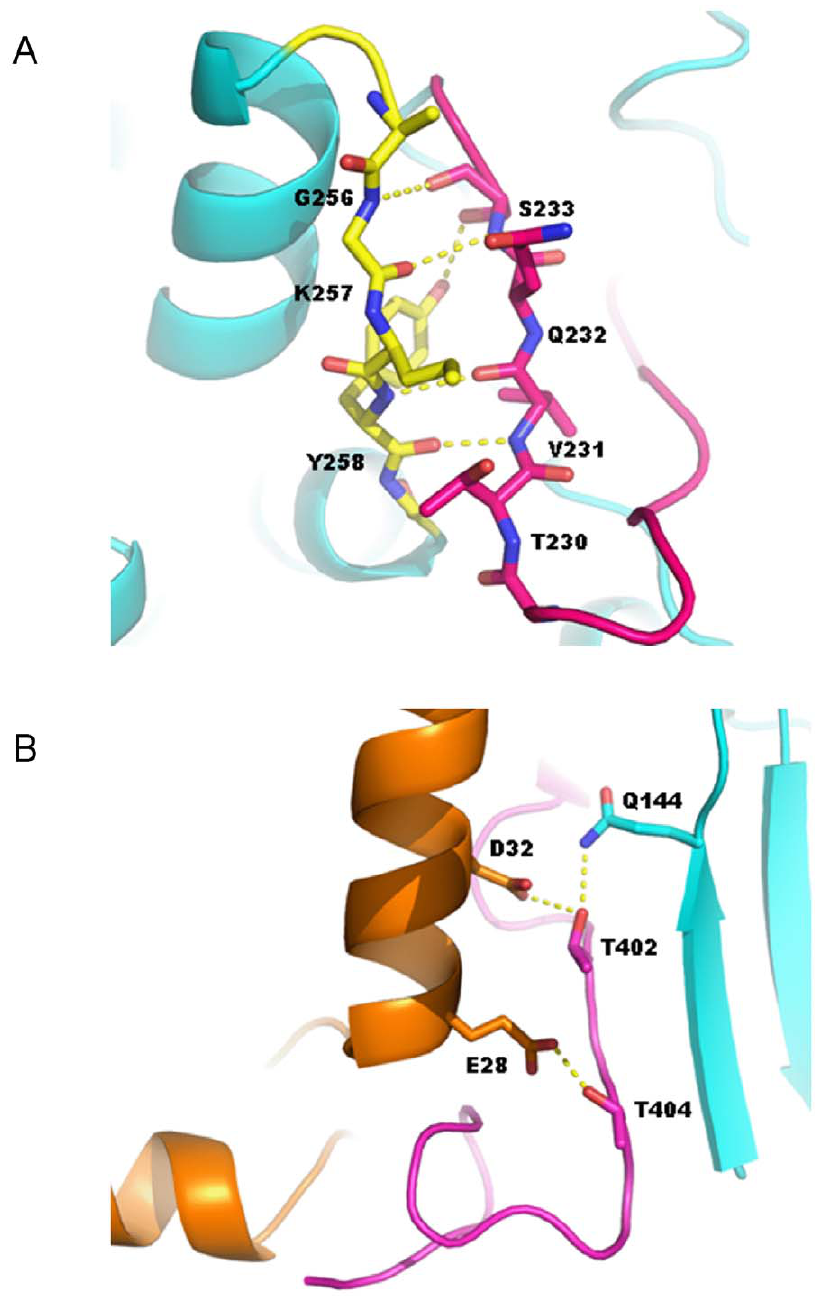
Figure 4. Detailed views of intramolecular interations. ( A ) Interactions involved in the small antiparallel b -sheet formed from a part of the activation loop (red) and a part of the a EF/ a F loop (yellow). ( B ) Hydrogen bonding interactions involved in the stabilization of the hydrophobic motif within the dimerization domain.